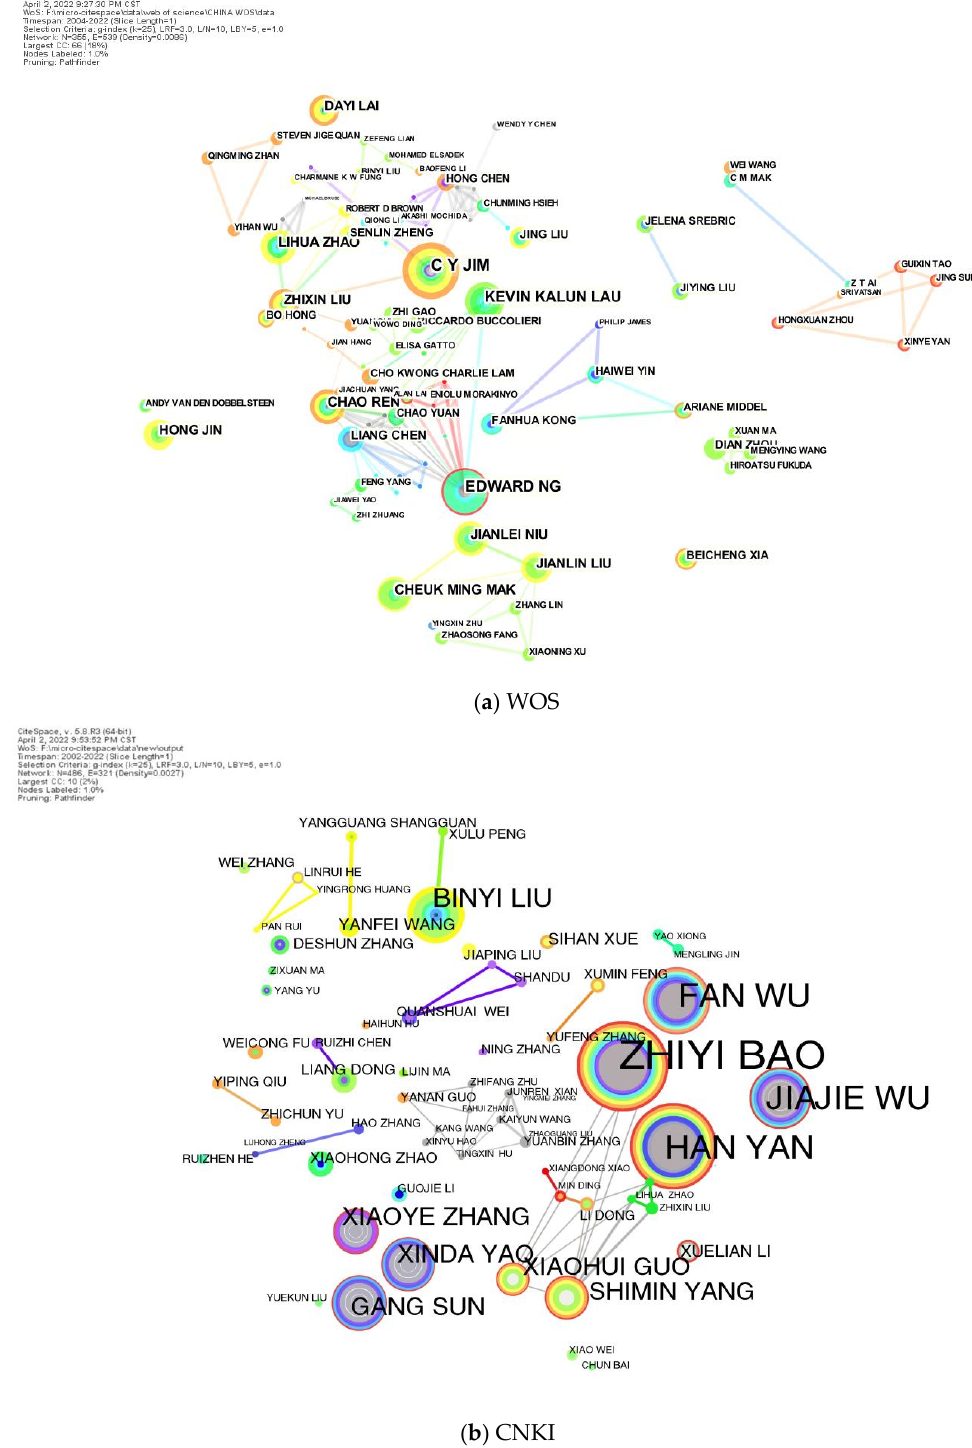
Figure 2. Authorship mapping of Chinese scholars in landscape microclimate.